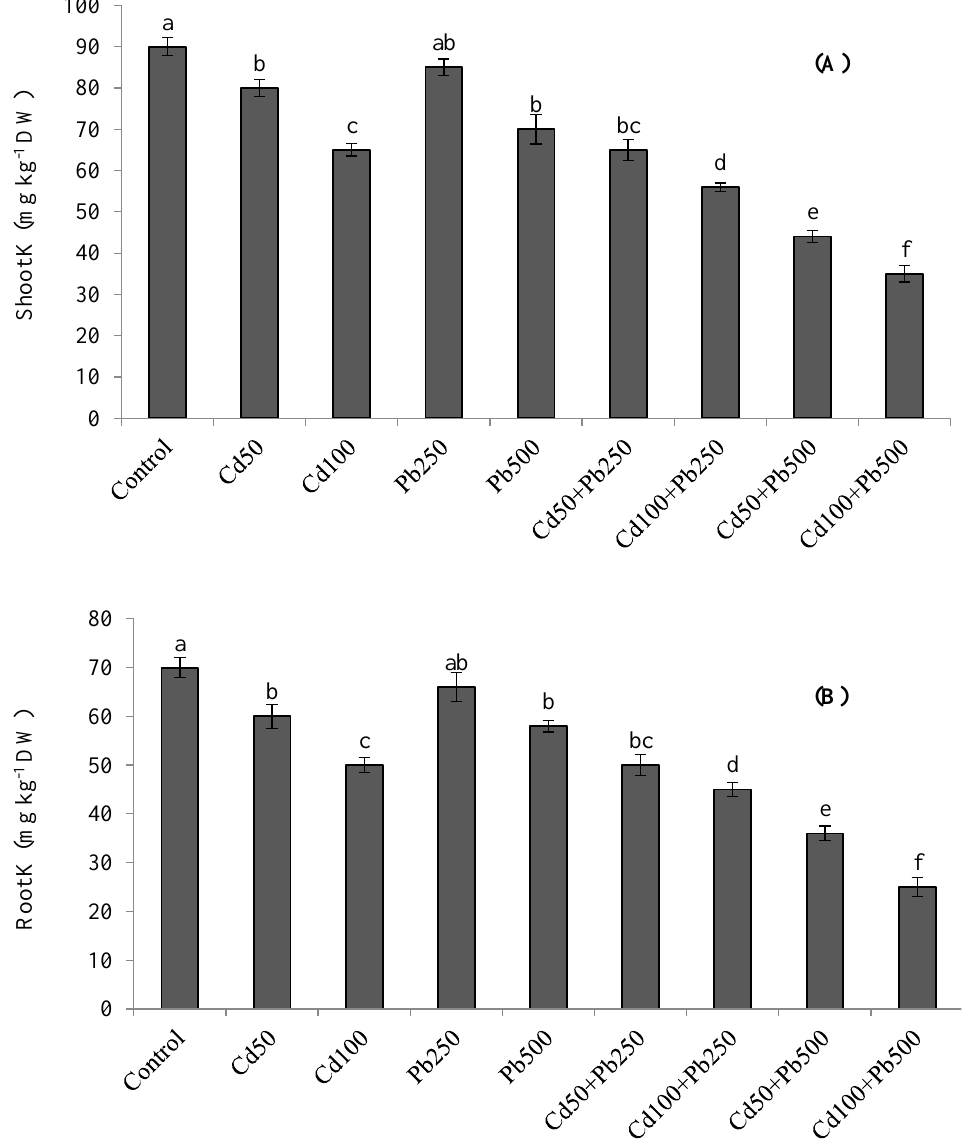
Figure 3. Effect of different levels of Cd, Pb and their combinations on shoot ( A ) and root ( B ) K concentrations. Different letters represent the significant difference among the treatments at a 5% significance level.